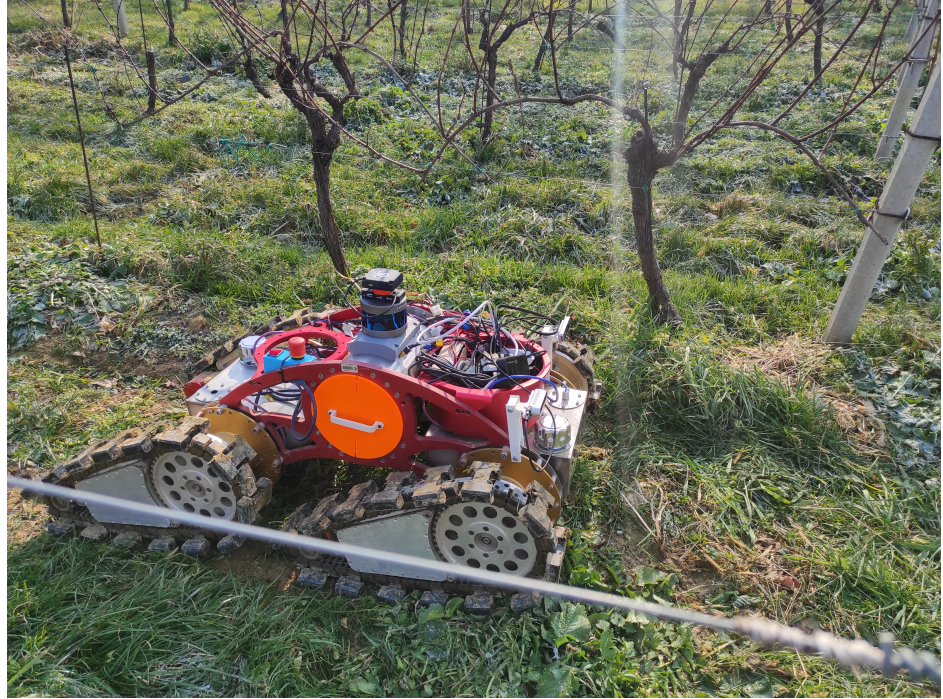
Figure 15. Position of the ATMR-VIV after reaching the specified goal next to the detected